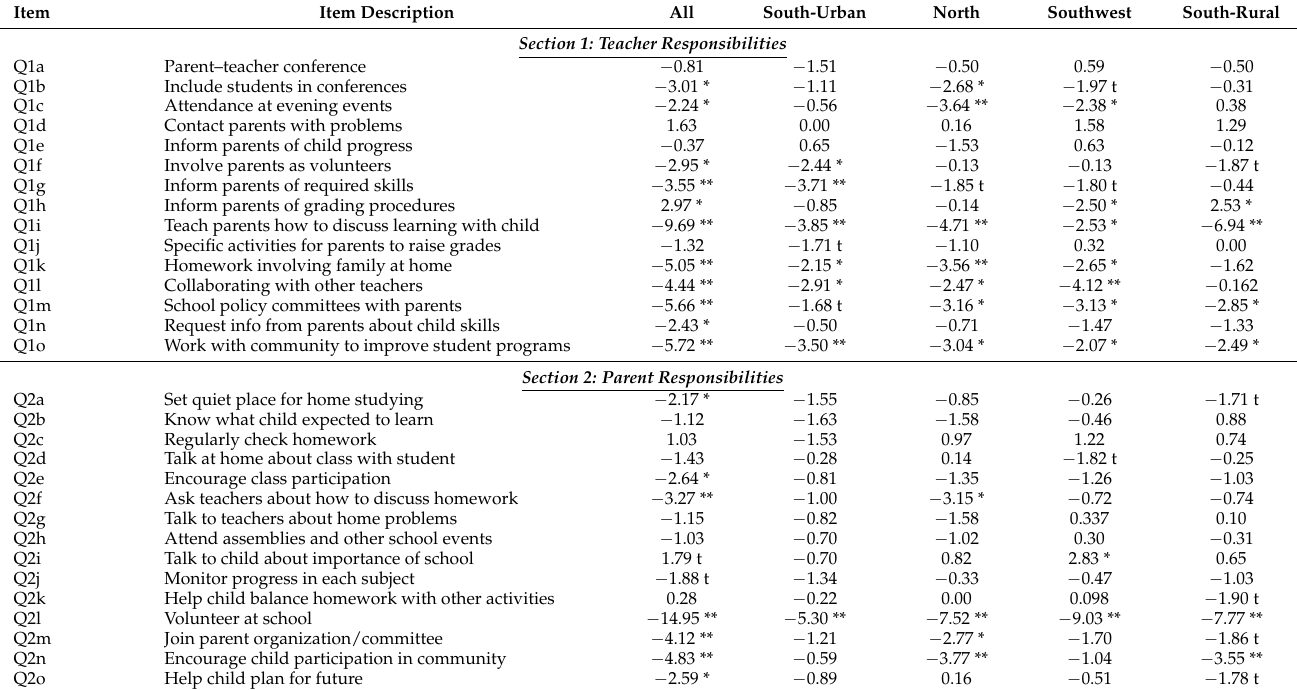
Table 3. t-Scores from paired-samples t -test results for pre and post mean attitude